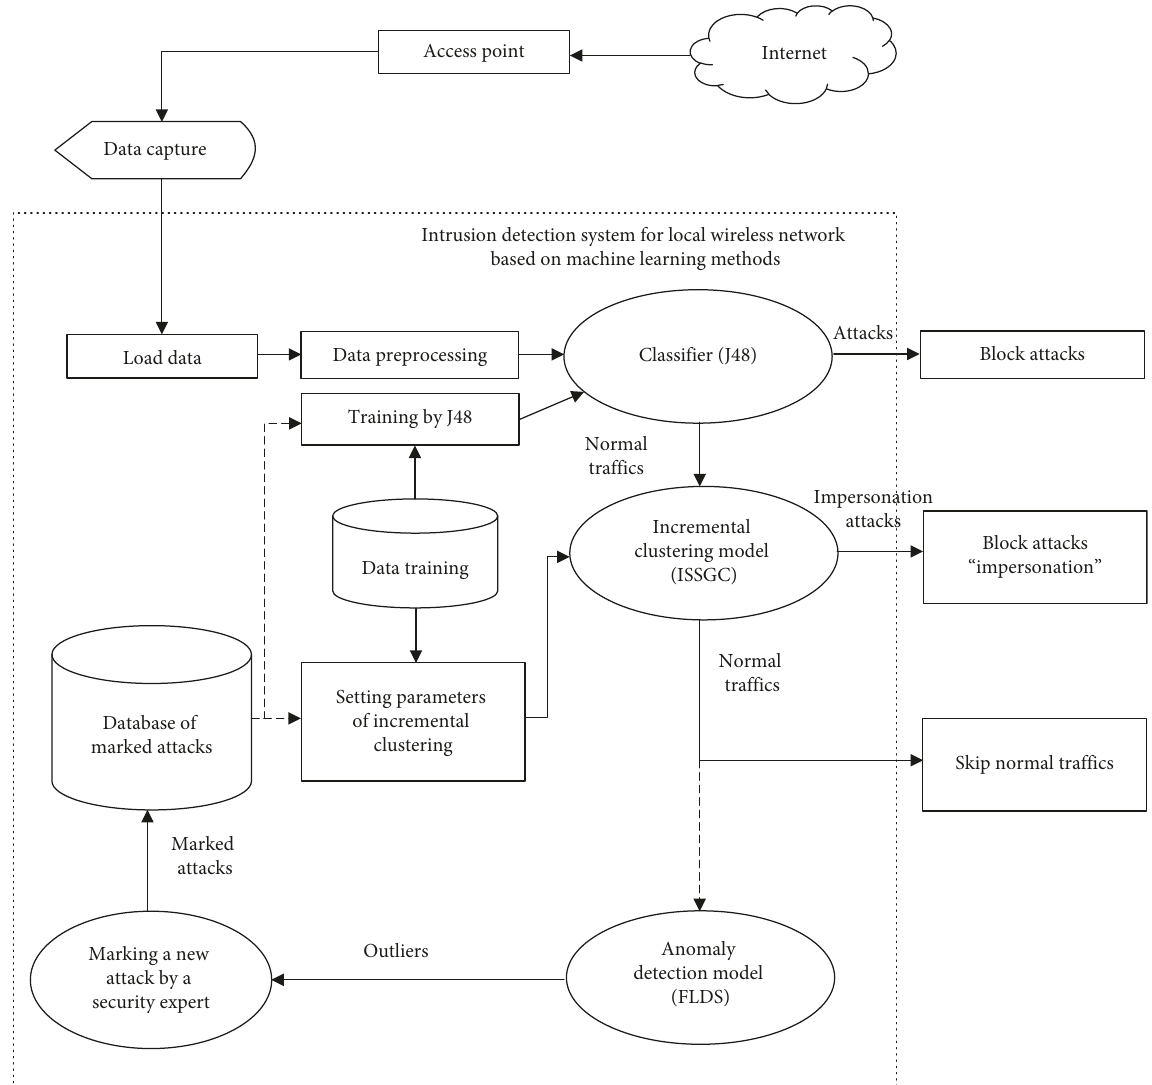
Figure 9: A new framework for intrusion detection in 802.11 networks.